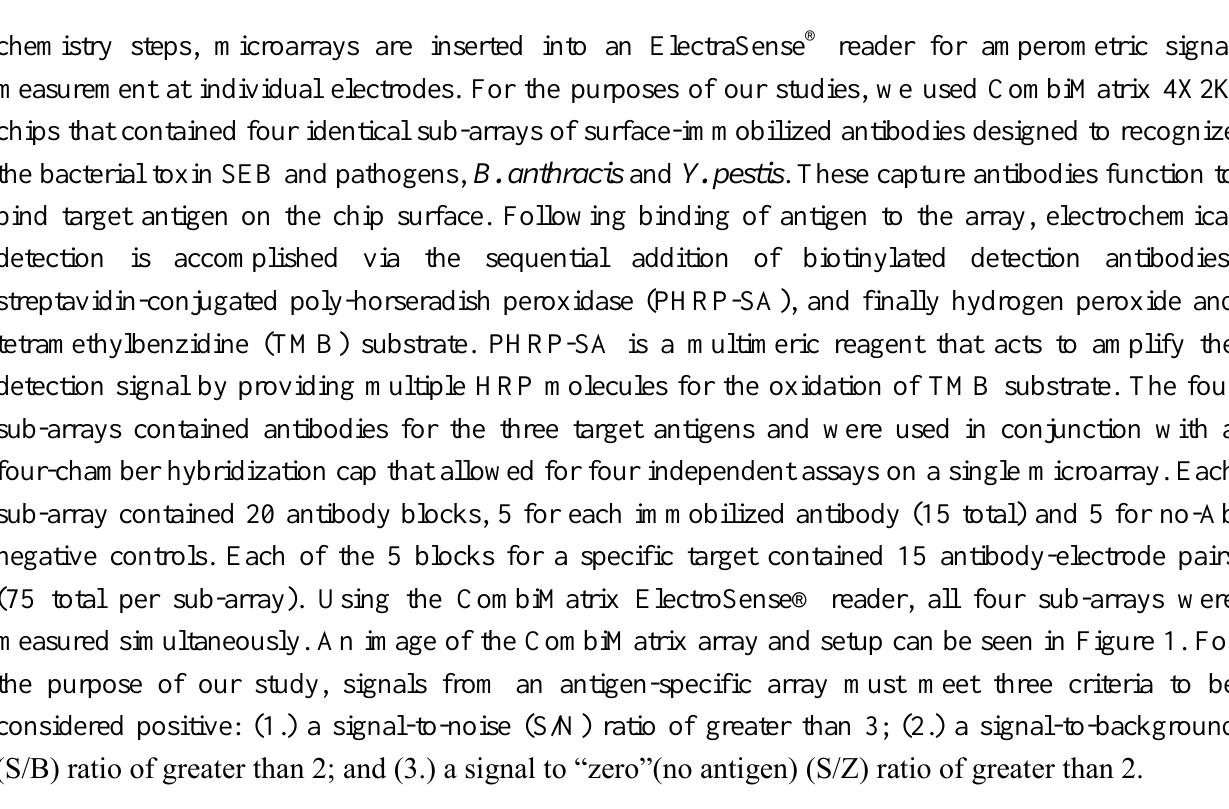
Figure 1. CombiMatrix antibody microarray ( A ) Arrays are subdivided into four identical sub-arrays divided into 20 discrete antibody blocks each; ( B ) Hybridization clamp that holds the chip and hybridization cap covering the microarray; ( C ) Fully assembled clamp, cap, and